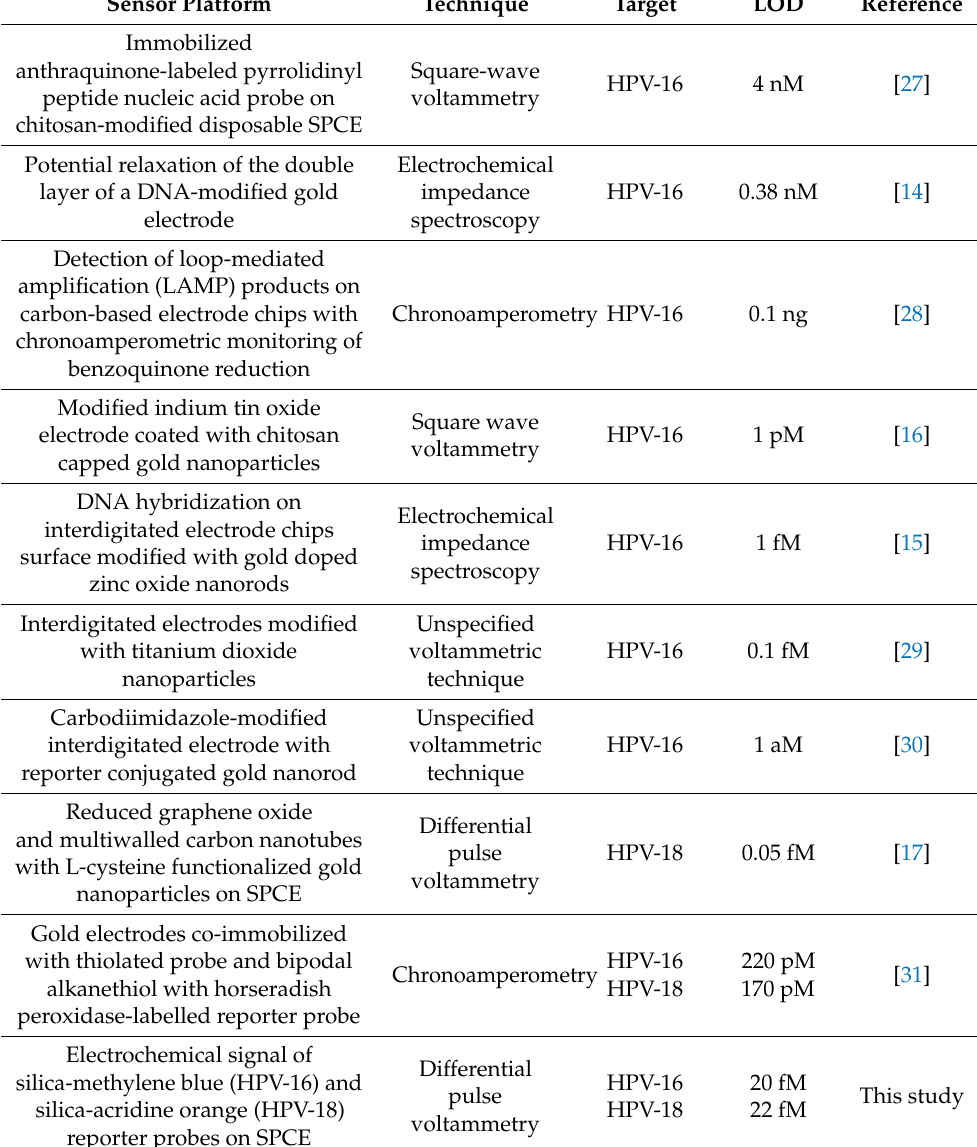
Table 2. Cont. Sensor Platform Technique Target LOD Reference Immobilized Square-wave chitosan-modified disposable SPCE